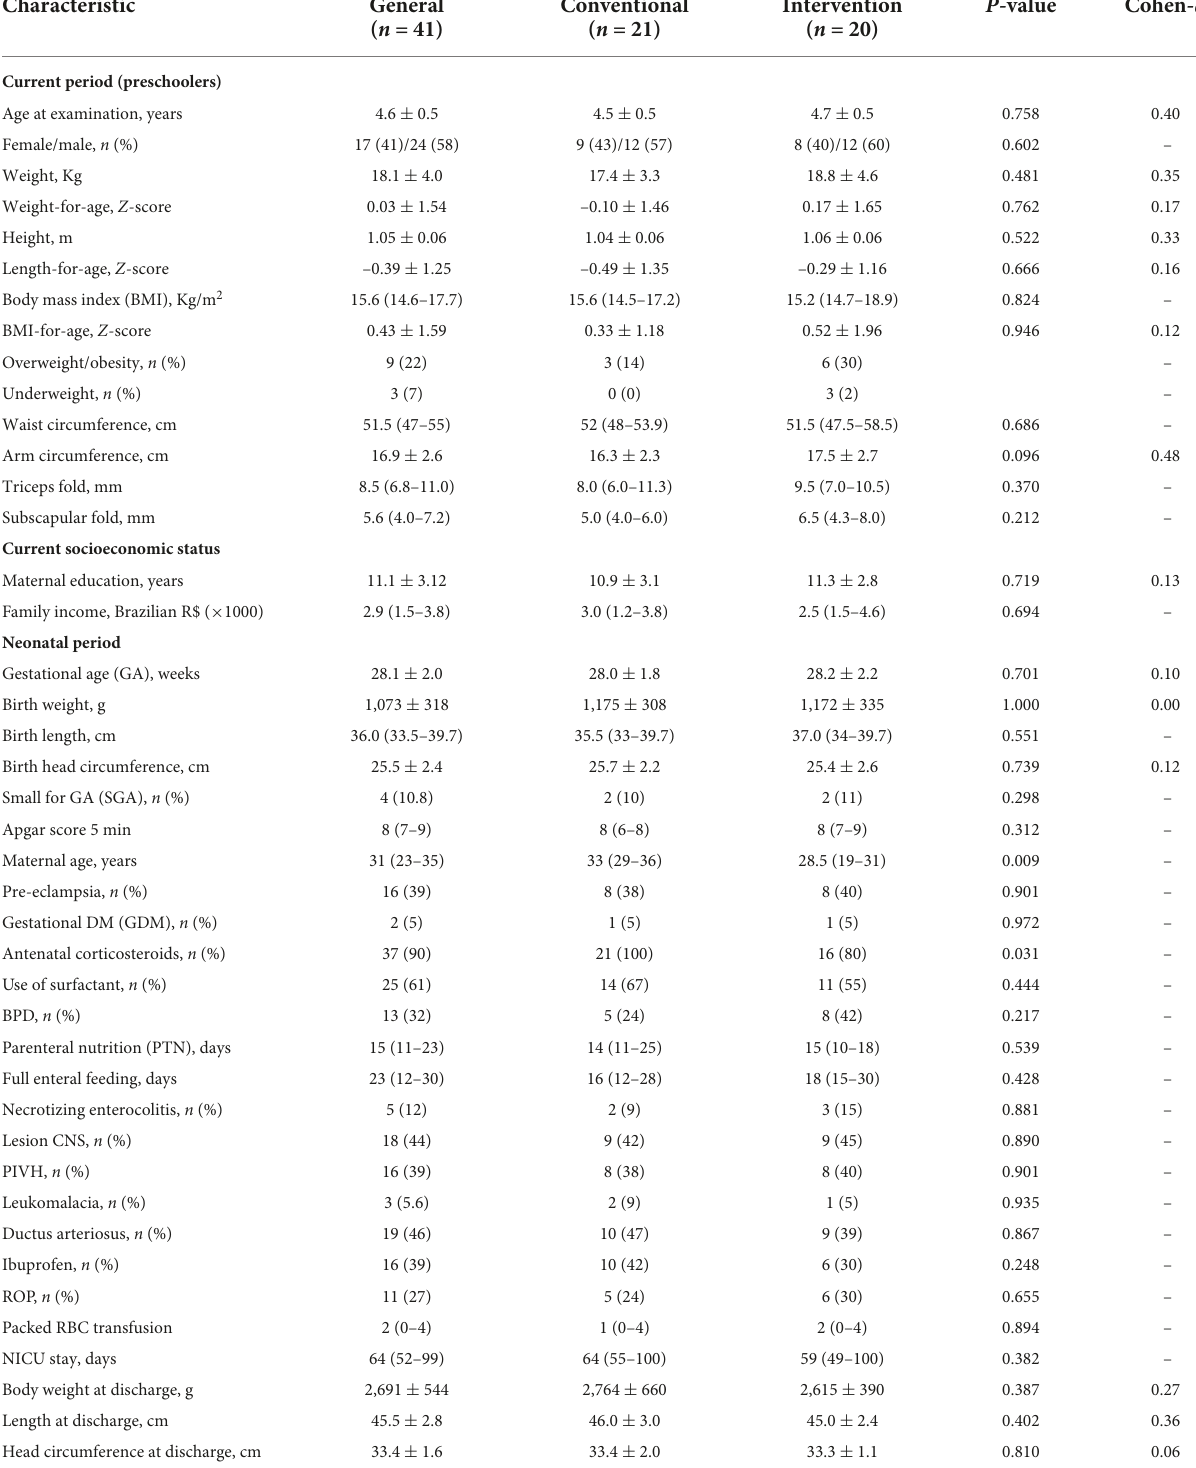
TABLE 1 Current and neonatal characteristics of preterm children subjected to the early intervention program compared to conventional care. Characteristic General Conventional ( n = 41) ( n =